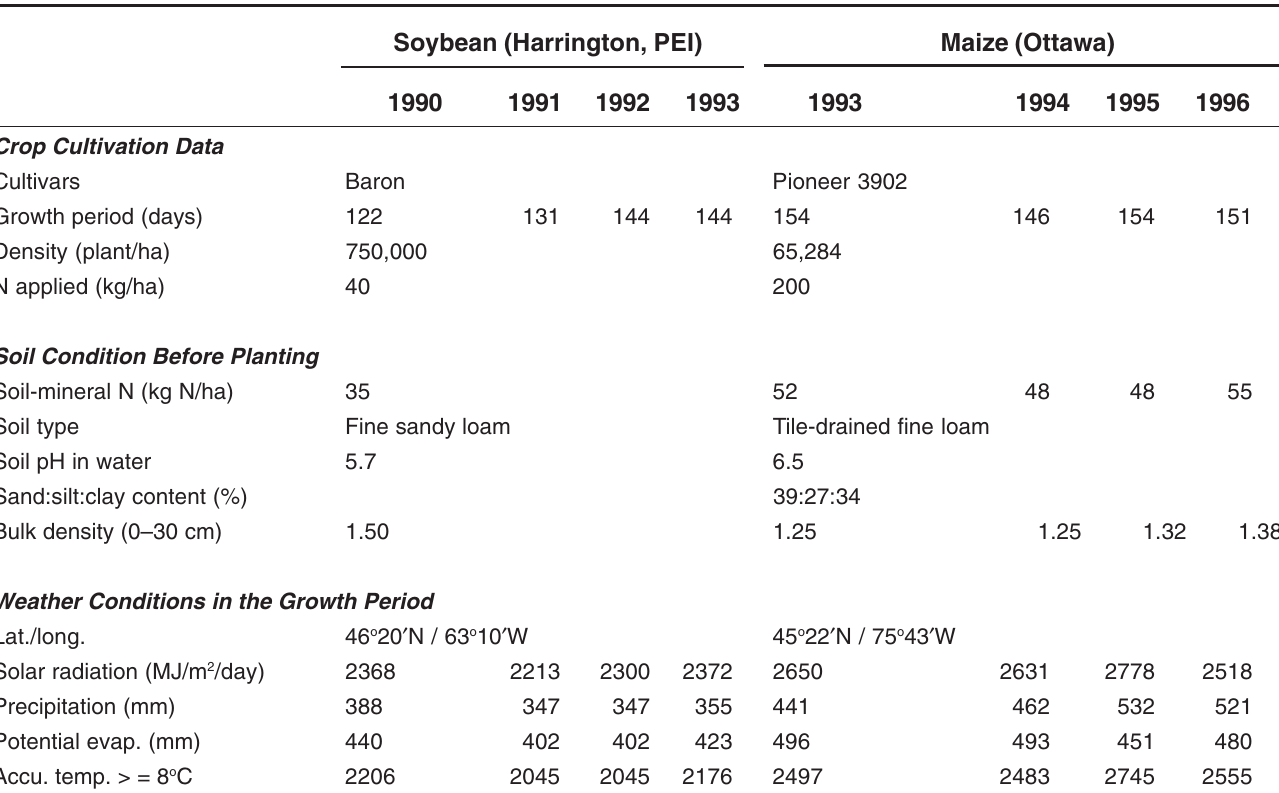
Results and Discussion